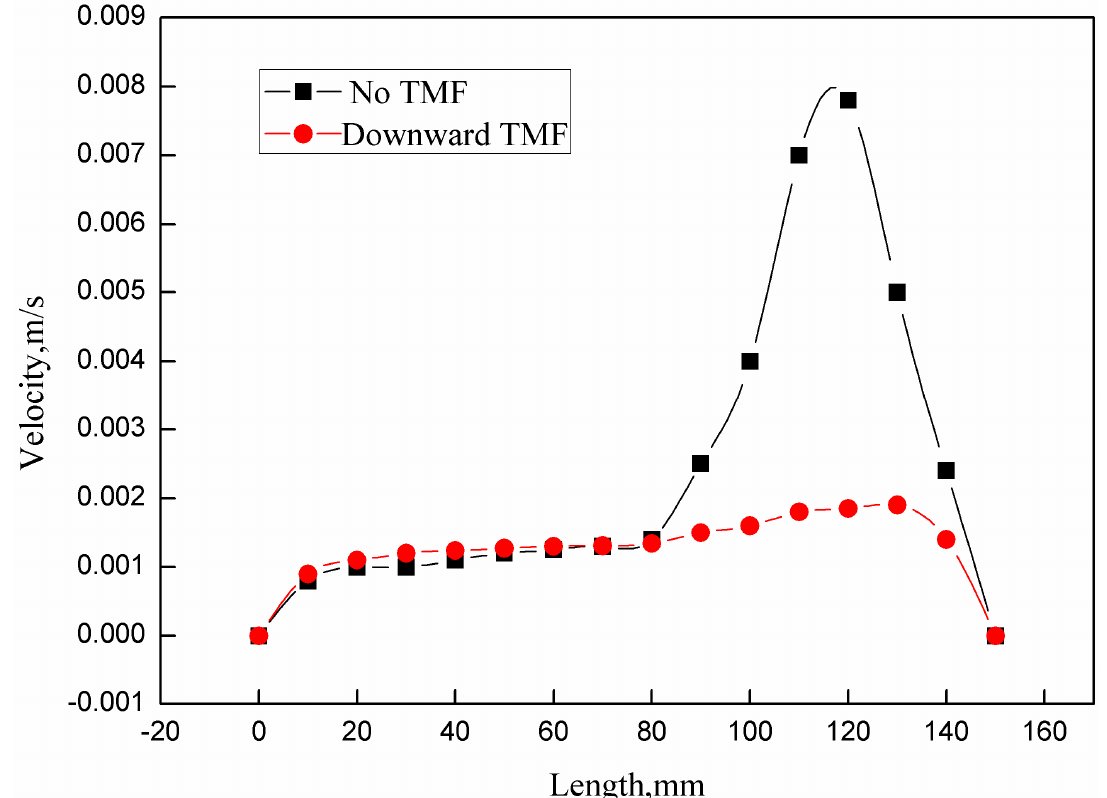
Figure 7. Time history of V during solidification, V refers to the average velocity ahead of the S/L interface. (Downward TMF I = 8 A, f = 50 Hz.) interface. (Downward TMF I = 8 A, f = 50